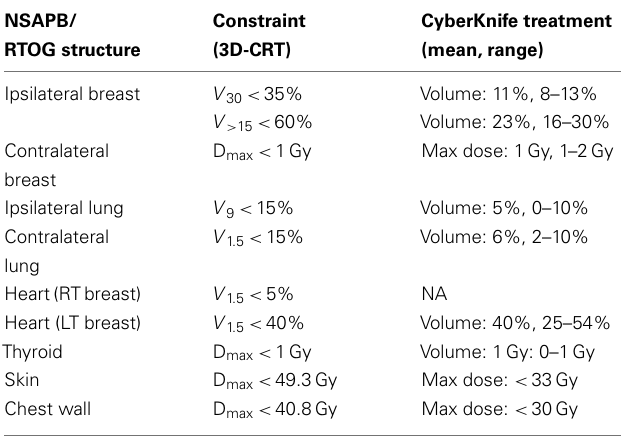
Table 2 | Dose limitations for normal tissue based on the NSABP-39/RTOG 0413, 3D-CRT protocol (Vicini andWhite, 2007) for the patients in this series ( n = 2) that received CyberKnifeAPBI to a total dose of 30Gy delivered in five fractions.